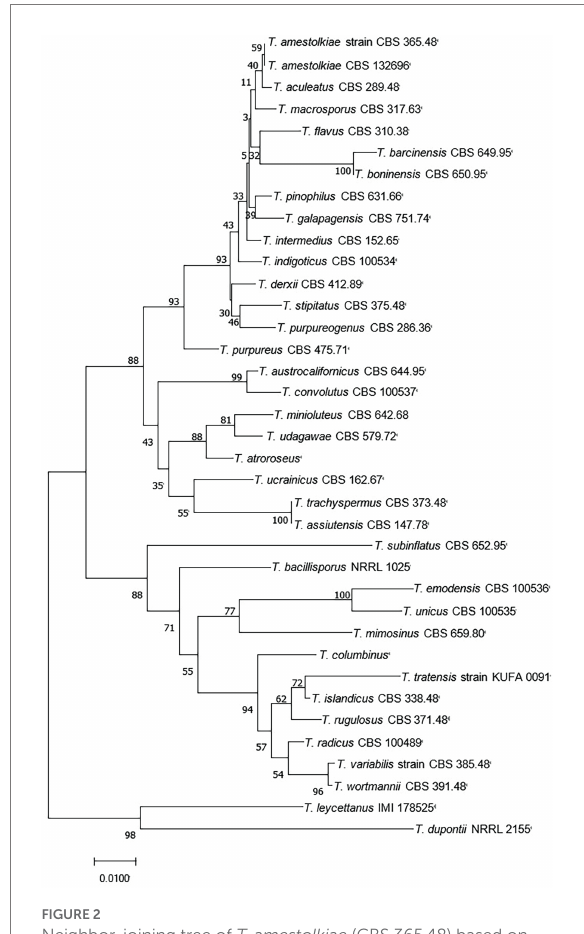
FIGURE 2 Neighbor-joining tree of T. amestolkiae (CBS 365.48) based on ITS